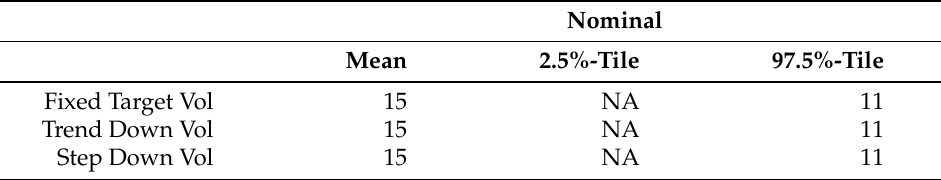
Table 16. Break Even Years at Different Target